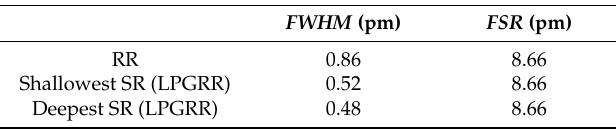
Figure 6. Zoom on the splitting resonances of core (blue curve) and cladding (red curve) spectral responses at ~ 1539 nm. Table 3. FWHM and FSR of the SRs of the LPGRR core spectrum and those of the resonance of a RR spectrum with the same length but without the LPG.